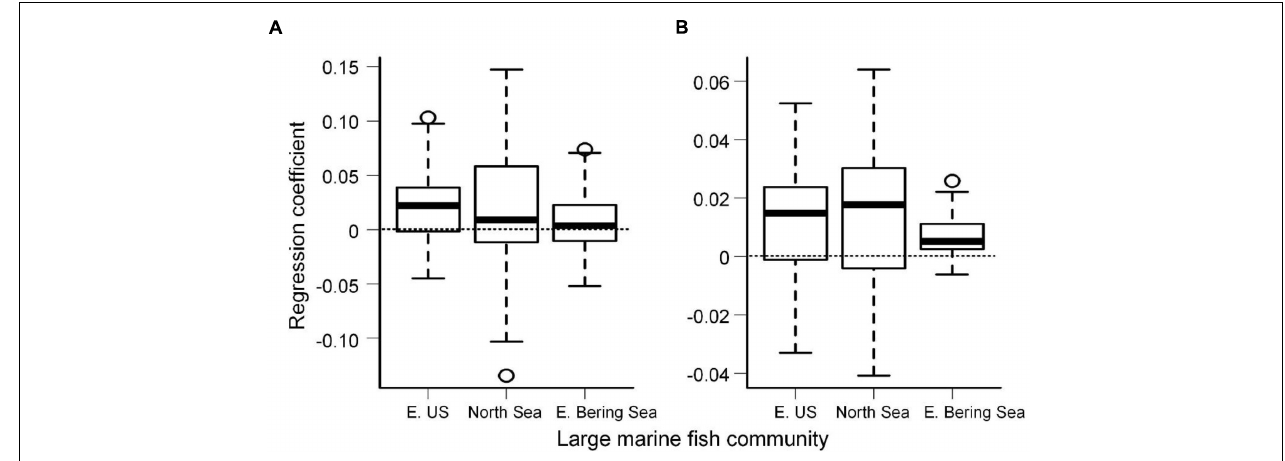
FIGURE 2 | Boxplots illustrating regression trends between mean sea surface temperature and mean spatial robustness (A) and mean spatial sensitivity (B) of individual species over time in the Eastern US Continental Shelf, the North Sea, and the Eastern Bering Sea. The horizontal dashed lines indicate regression coefficients, i.e., slope, equal to 0. TABLE 1 | Number of species showing different responses to underlying factors with time correlating species geographical interaction networks.